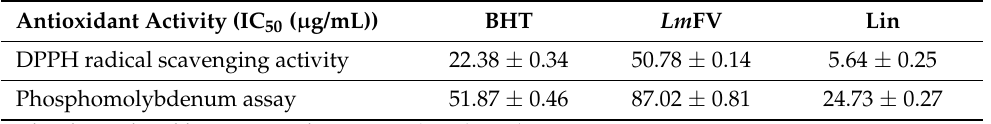
Table 4. IC 50 s of BHT, Lm FV, and Lin for different antioxidant systems. Antioxidant Activity (IC 50 ( µ g/mL)) BHT Lm FV Lin DPPH radical scavenging activity 22.38 ± 0.34 50.78 ± 0.14 5.64 ± 0.25 Phosphomolybdenum assay 51.87 ± 0.46 87.02 ± 0.81 24.73 ±